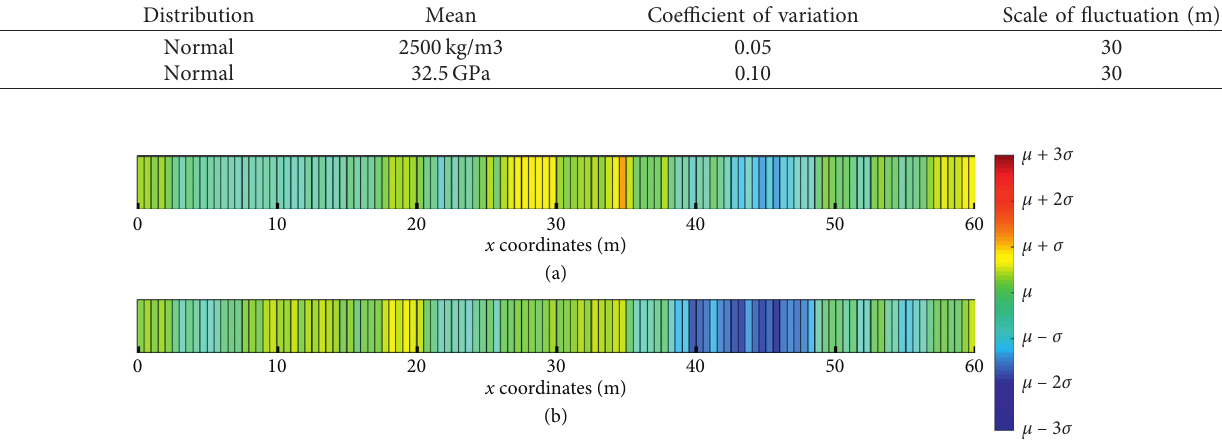
Figure 3: An example realization of the random fields of mass density and Young’s modulus with 120 elements. The beam has a span of 60m.